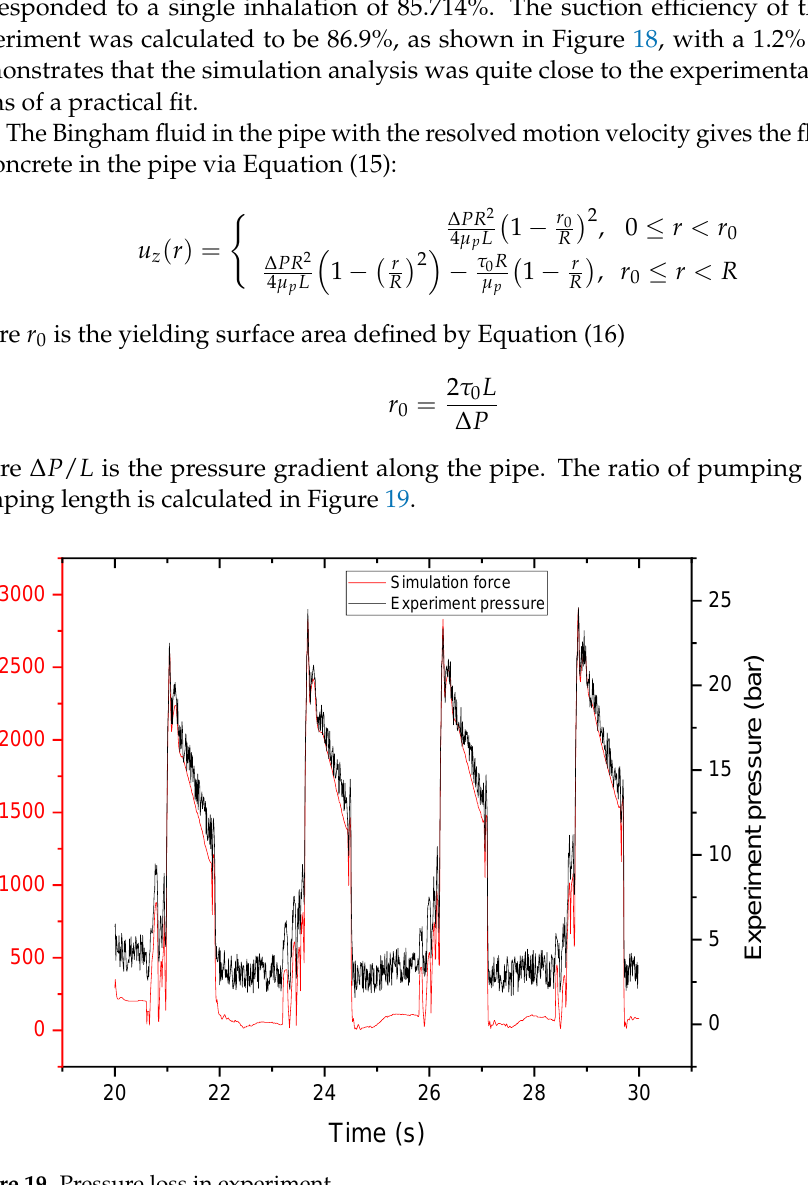
Figure 19. Pressure loss in experiment.